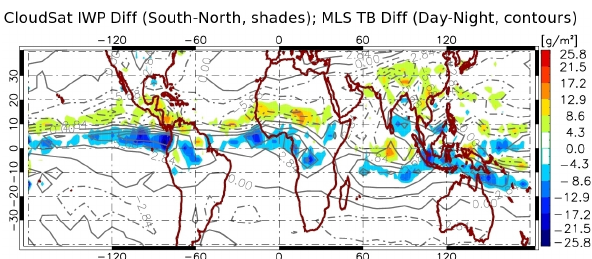
Figure 10. CloudSat (cid:49) IWP (color shades) and Aura MLS 640GHz (cid:49)T B (descending minus ascending orbits to mimic CloudSat view- ing geometry, shown in contours; dashed is negative, solid is pos- itive) for JJA, 2007–2010. The maps are interpolated to a 2 ◦ × 2 ◦ grid box, and the correlation coefficient is − 0.68. Note that MLS has a shallower viewing angle, and it has a cloud diurnal cycle em- bedded in the